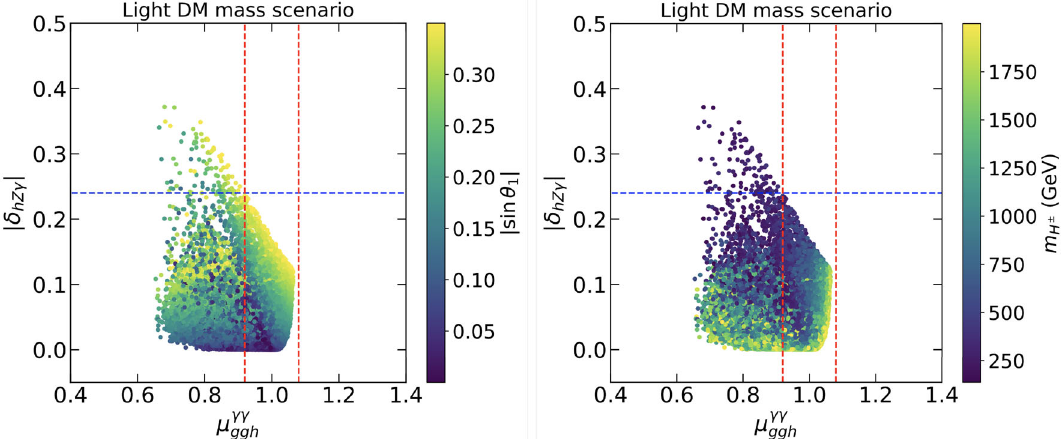
Fig. 17 Same as Fig. 16 but for the light DM mass